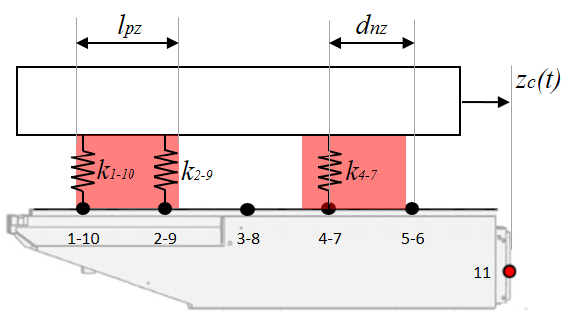
Figure 6. Sti ff ness of the slider. Lumped-sti ff ness is associated to each contact Figure 6. Stiffness of the slider. Lumped-stiffness is associated to each contact node.